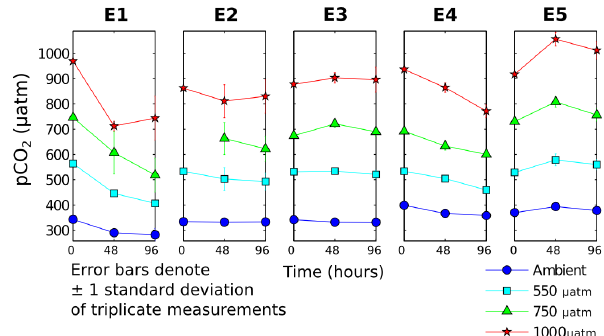
Figure 2. Evolution of p CO 2 in five bioassay experiments across three time points for all p CO 2 treatments. Legend shows the colours and symbols used to denote the different p CO 2